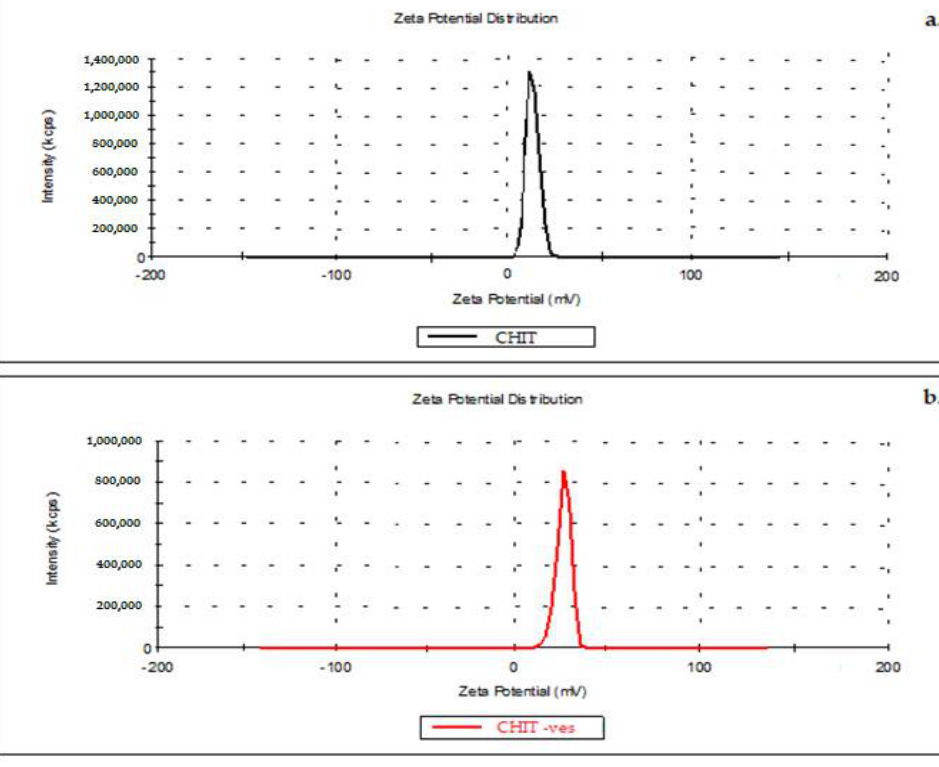
Figure 3. Zeta potential distribution of chitosan solution ( a ) and chitosan vesicles ( b ). SEM micrography (Figure 4a) indicates the presence of vesicles that tend to clump during drying on the sample holder. In SEM microscopy, the sample deposited on the support is covered with a metallic layer that protects it, so that the obtained image high- lights the morphology of the analyzed surface.The dimensional histogram is made on the vesicles in the fields that do not contain agglomerations (Figure 4b). ( a )